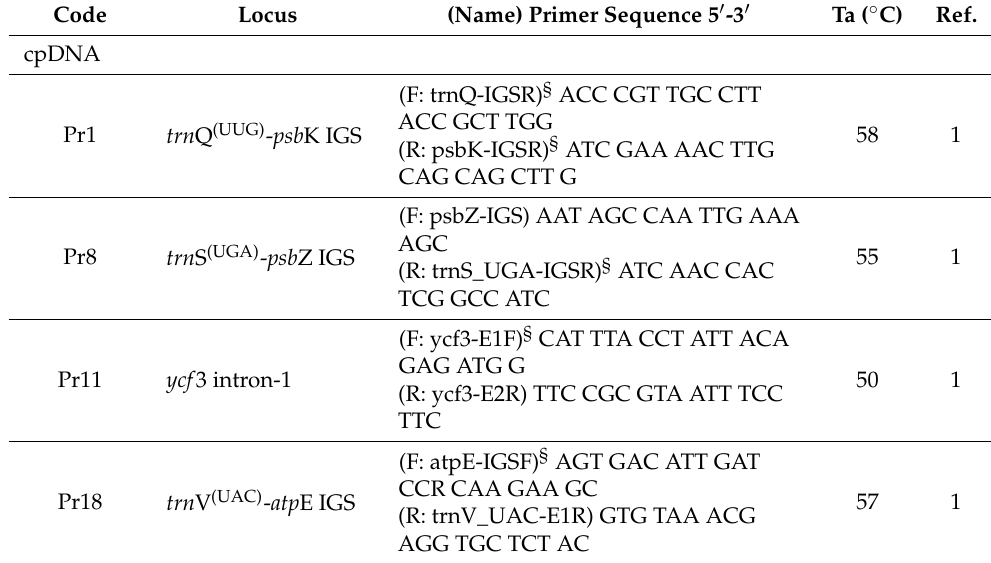
Table 2. Information on the molecular markers